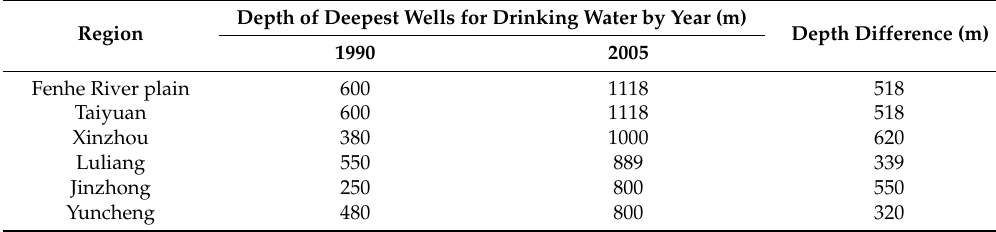
Table 7. Depth of deepest wells for drinking water in rural areas in the Fenhe River plain. Depth of Deepest Wells for Drinking Water by Year (m) Region Depth Difference (m) 1990 2005 Fenhe River plain 600 1118 518 Taiyuan 600 1118 518 Xinzhou 380 1000 620 Luliang 550 889 339 Jinzhong 250 800 550 Yuncheng 480 800